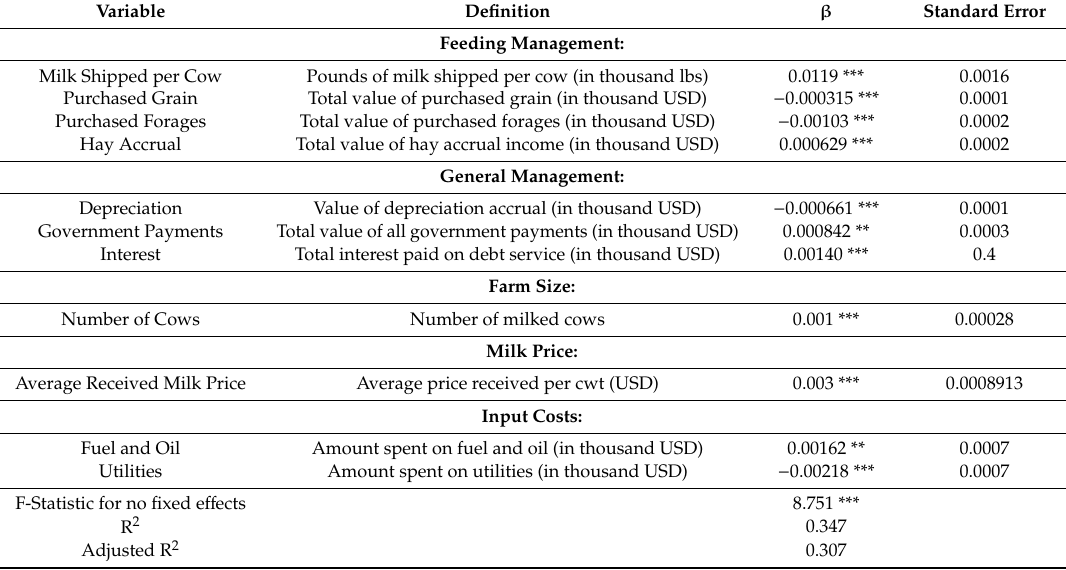
Table 2. Estimated parameters of the regression model (n =